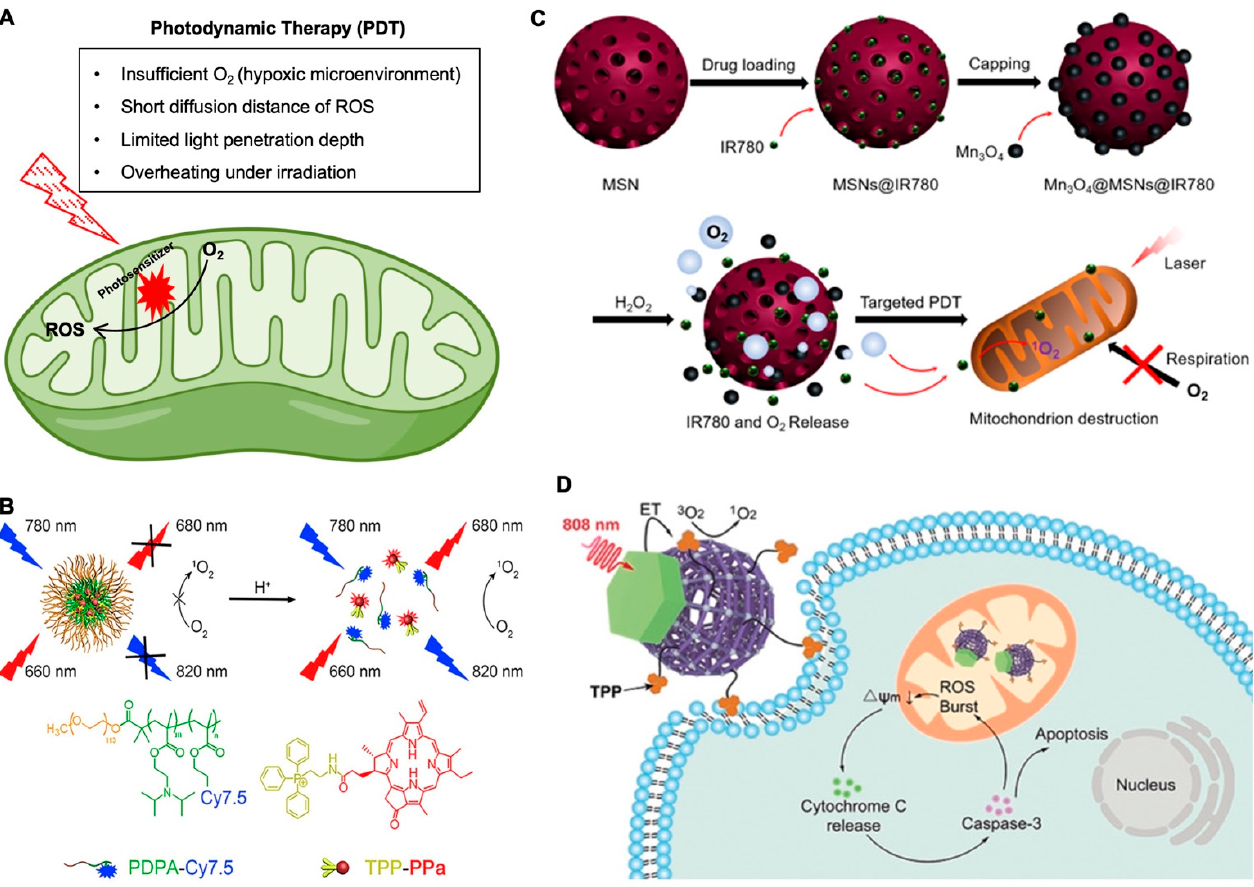
Figure 2. Mitochondria-targeting in photodynamic therapy. ( A ) A schematic illustration of mitochondria-targeting photodynamic therapy and its major challenges. ( B ) A pH-activatable mesoporous silica nanoparticle (MSN)-based platform for dual-stage precisely mitochondria-targeted photodynamic anticancer therapy [60]. ( C ) Self-generating oxygen enhanced mitochondria-targeted photodynamic therapy for tumor treatment with hypoxia scavenging [61]. ( D ) Nd3+-Sensitized upconversion metal-organic frameworks for mitochondria-targeted amplified photodynamic therapy [69]. Reproduced with permission from references [60] (Copyright 2019 by Elsevier), [61] (Open access article distributed under the terms of the Creative Commons Attribution License), and [69] (Copyright 2019 by John Wiley and Sons) for the images in ( B – D ), respectively.